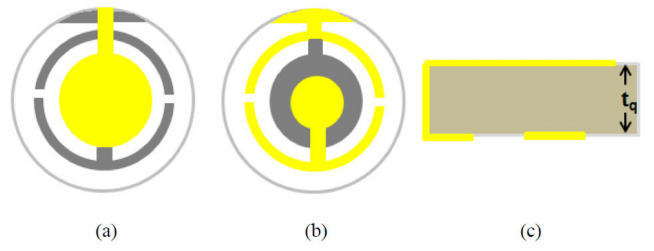
Figure 1. A typical quartz crystal resonator used in a QCM sensor ( a ) the top view of the quartz crystal, which shows a circular gold electrode in the center, ( b ) the bottom view of the crystal, and ( c ) the